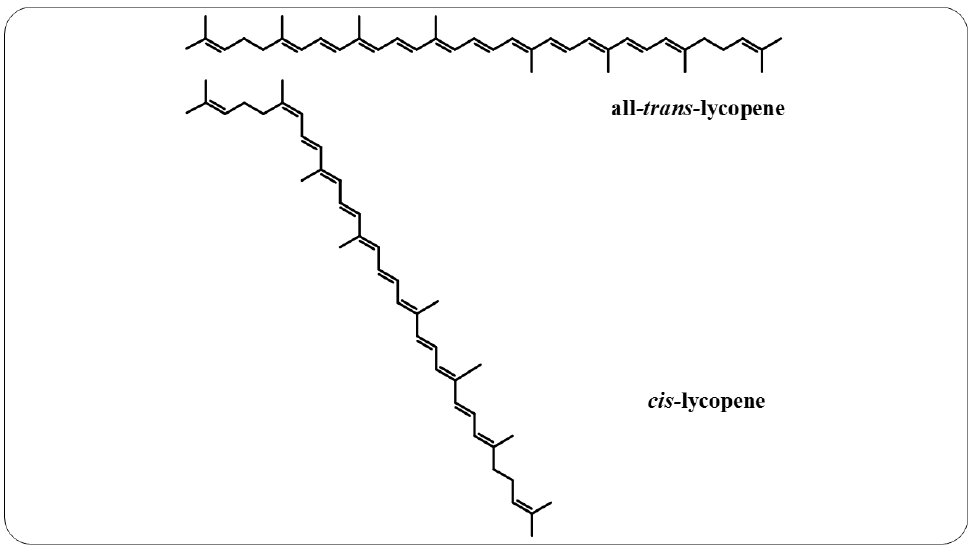
Figure 6. All -trans -lycopene and cis -lycopene structures. Figure 6. All- trans -lycopene and cis -lycopene